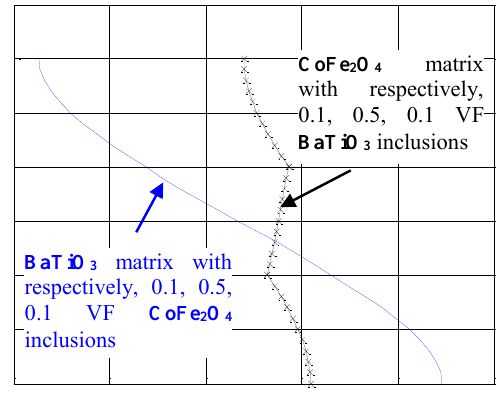
Figure 5: Variation of the magnetic potential along the thickness direction in the sandwich plate caused by a surface load on the top